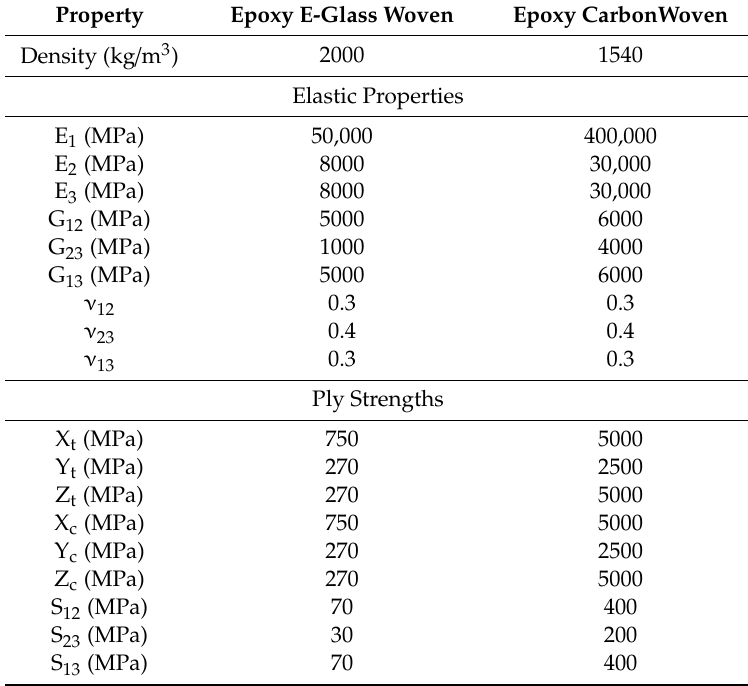
Table 7. Material properties of epoxy e-glass woven and epoxy carbon woven